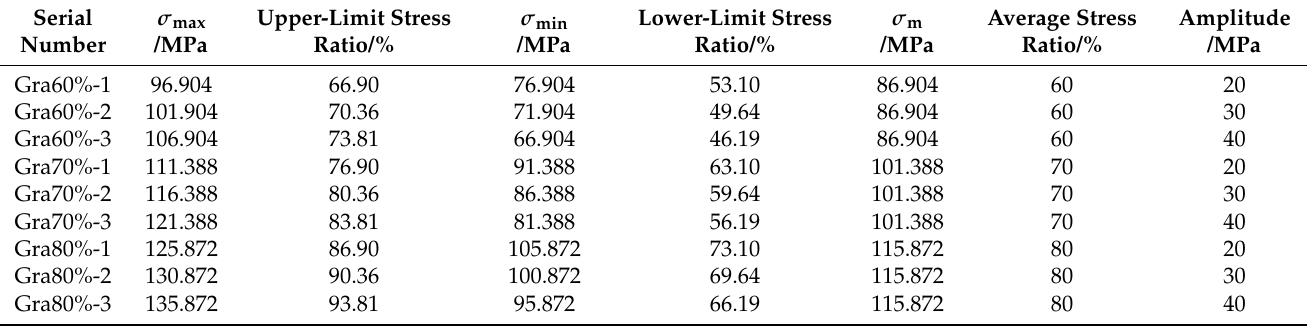
Table 2. Mechanical test schemes under cyclic dynamic disturbances.